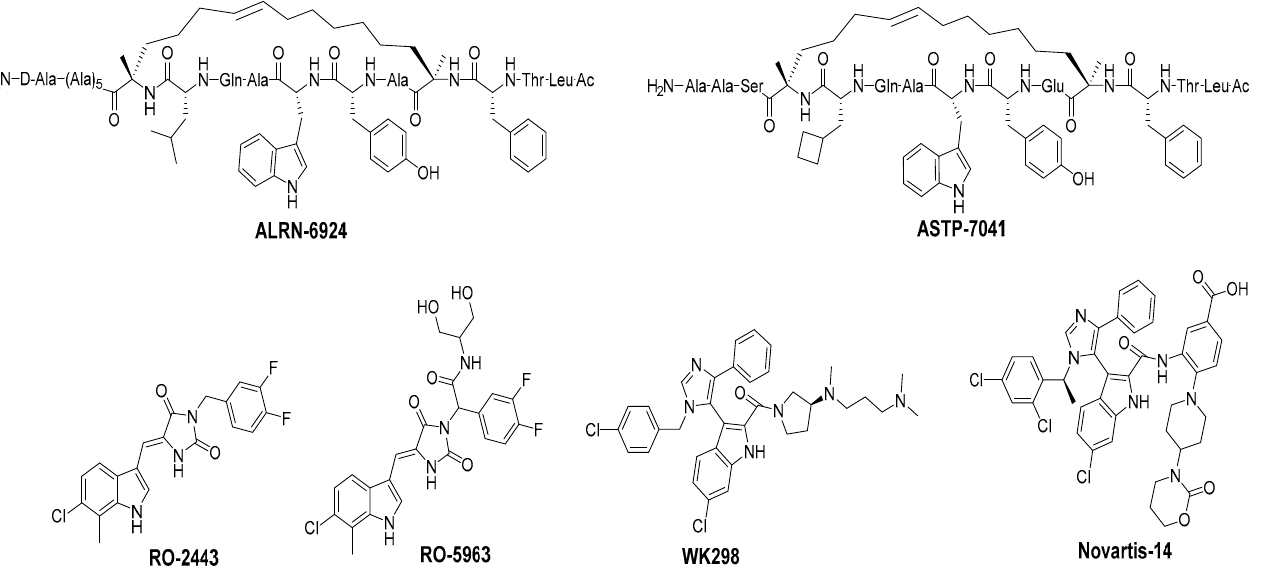
Figure 9. Chemical structure of MDMX inhibitors.